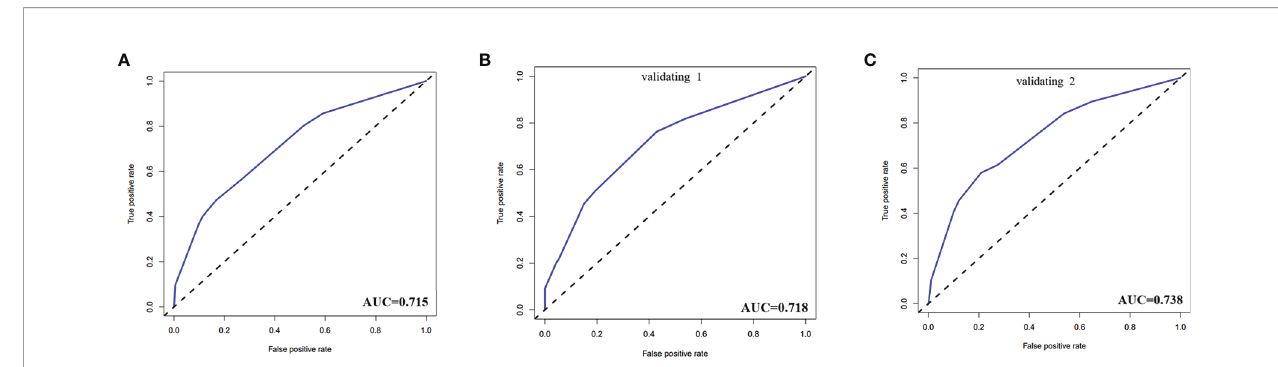
FIGURE 6 | (A) The receiver operating characteristics (ROC) curve and area under the curve (AUC) in the training cohort. (B) ROC curve and AUC in the validating 1 cohort. (C) ROC curve and AUC in the validating 2 cohort. Validating 1 and validating 2 were performed to evaluate the accuracy of this